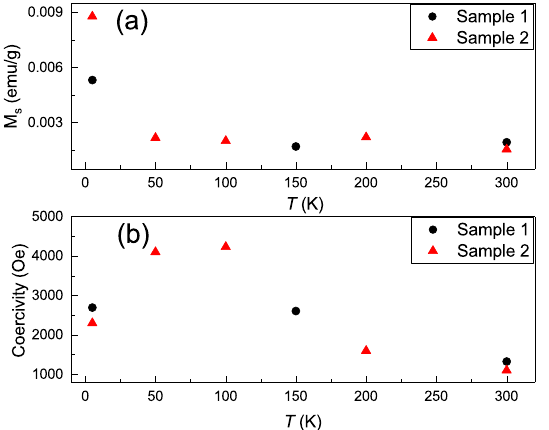
Figure 3. ( a ) The saturation magnetization as a function of temperature for two WSe 2 /MoSe 2 powders. ( b ) The temperature dependent coercivity fields of two WSe 2 /MoSe 2